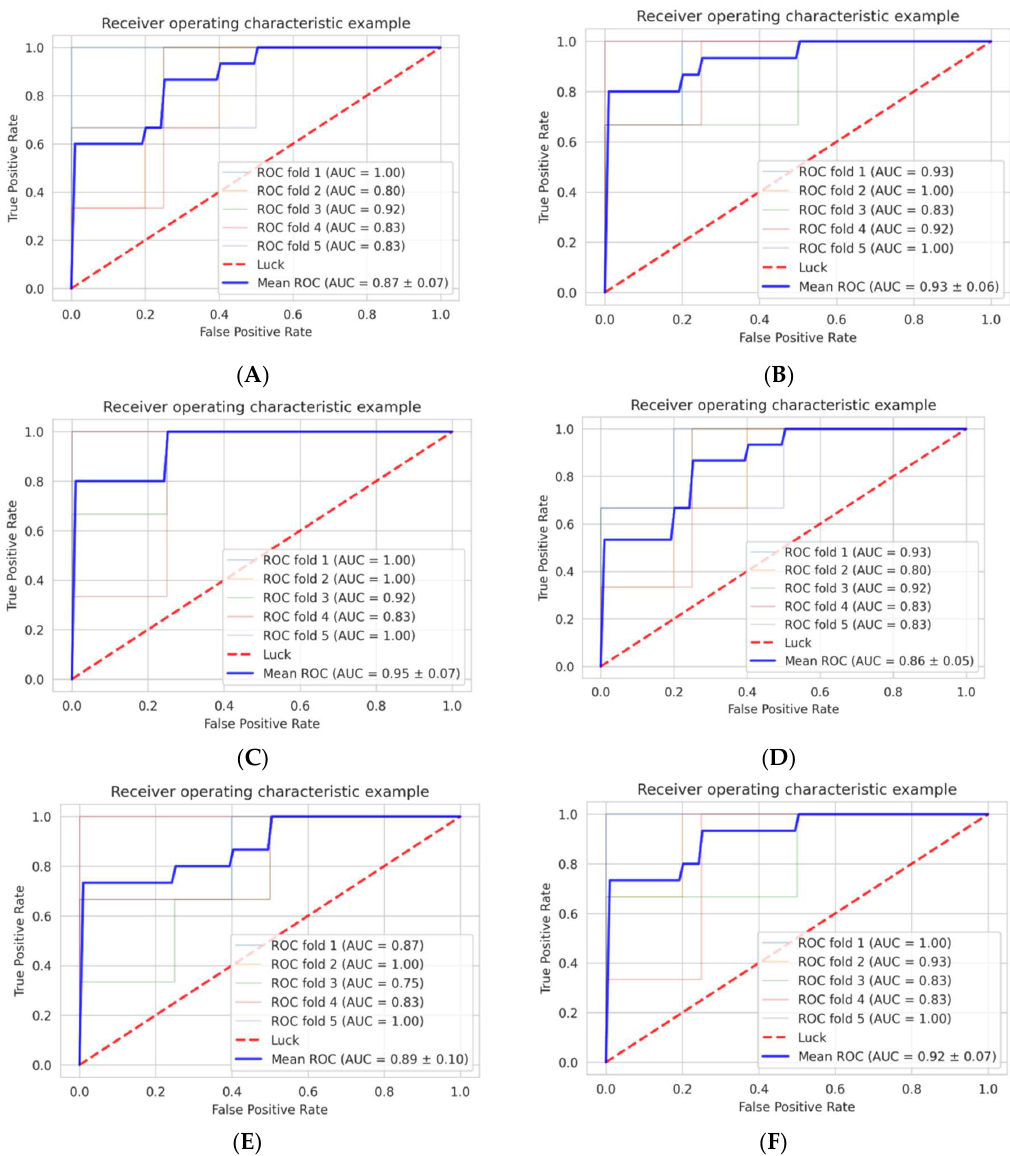
Figure 3. Diagnostic accuracy of the machine learning models in the training dataset (refer to Figure 2). ( A ) The AUC of the model with T2 logistic regression. ( B ) The AUC of the model with GdT1 logistic regression. ( C ) The AUC of the model with T2 and GdT1 logistic regression. ( D ) The AUC of the model with T2 SVM. ( E ) The AUC of the model with GdT1 SVM. ( F ) The AUC of the model with T2 and GdT1 SVM. The number of each mean ROC represents mean +/− standard deviation of the 6 AUCs. Abbreviations: receiver operating characteristics—ROC; area under the curve—AUC; T2